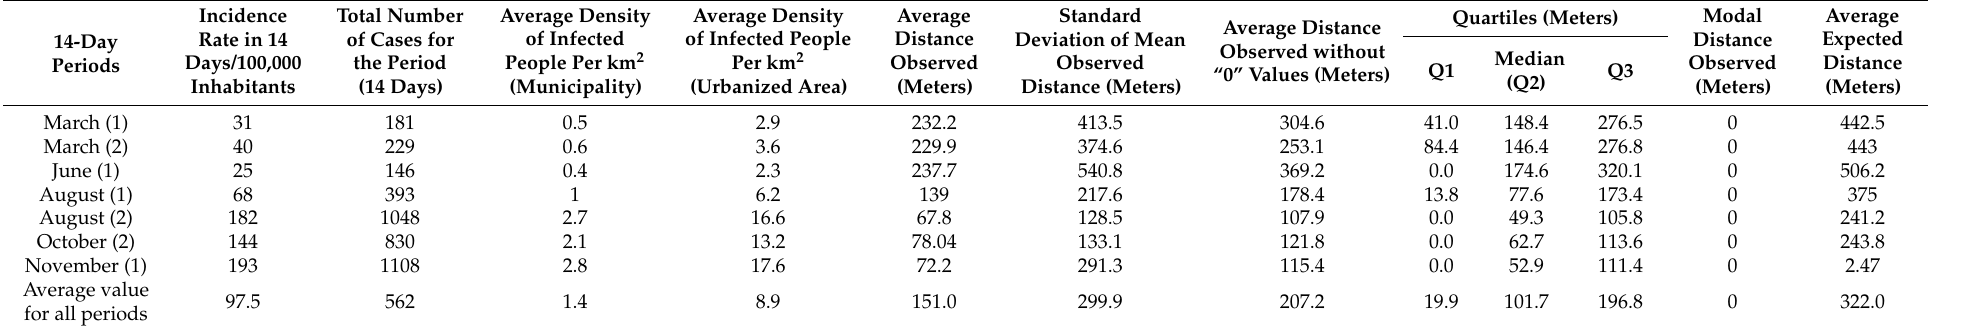
Table 4. Summary of the basic statistical data for the different epidemiological